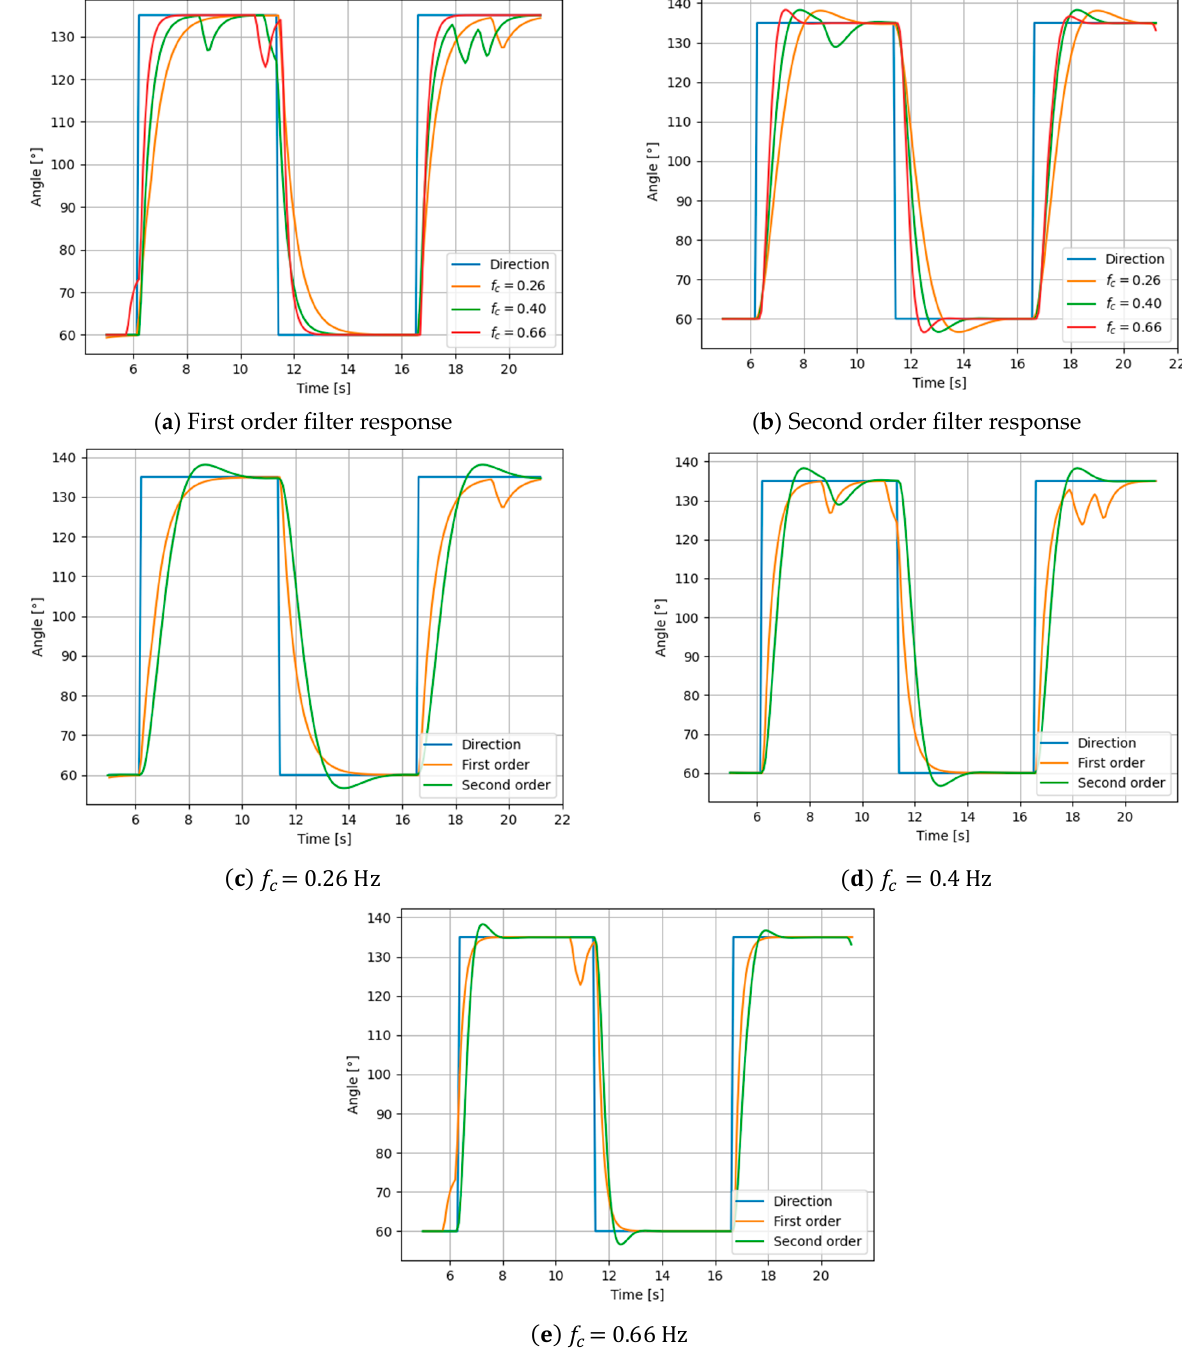
Figure 8. Low pass filter responses.